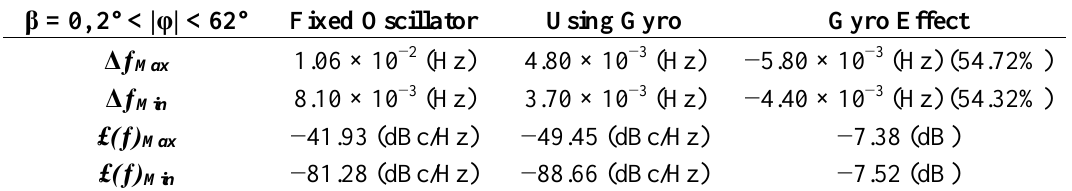
Figure 17. Average instability caused by sinusoidal vibration. ( a ) Frequency jitter; ( b ) Phase noise. Table 5. Average efficiency of gyroscopic mounting for sinusoidal vibration.